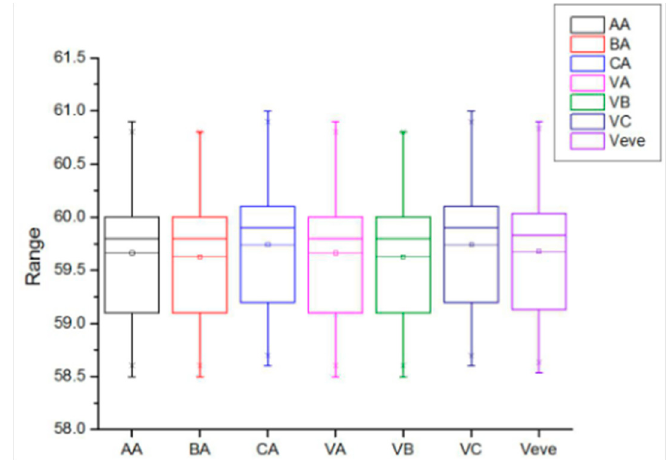
Figure 2. Workshop index data box diagram.